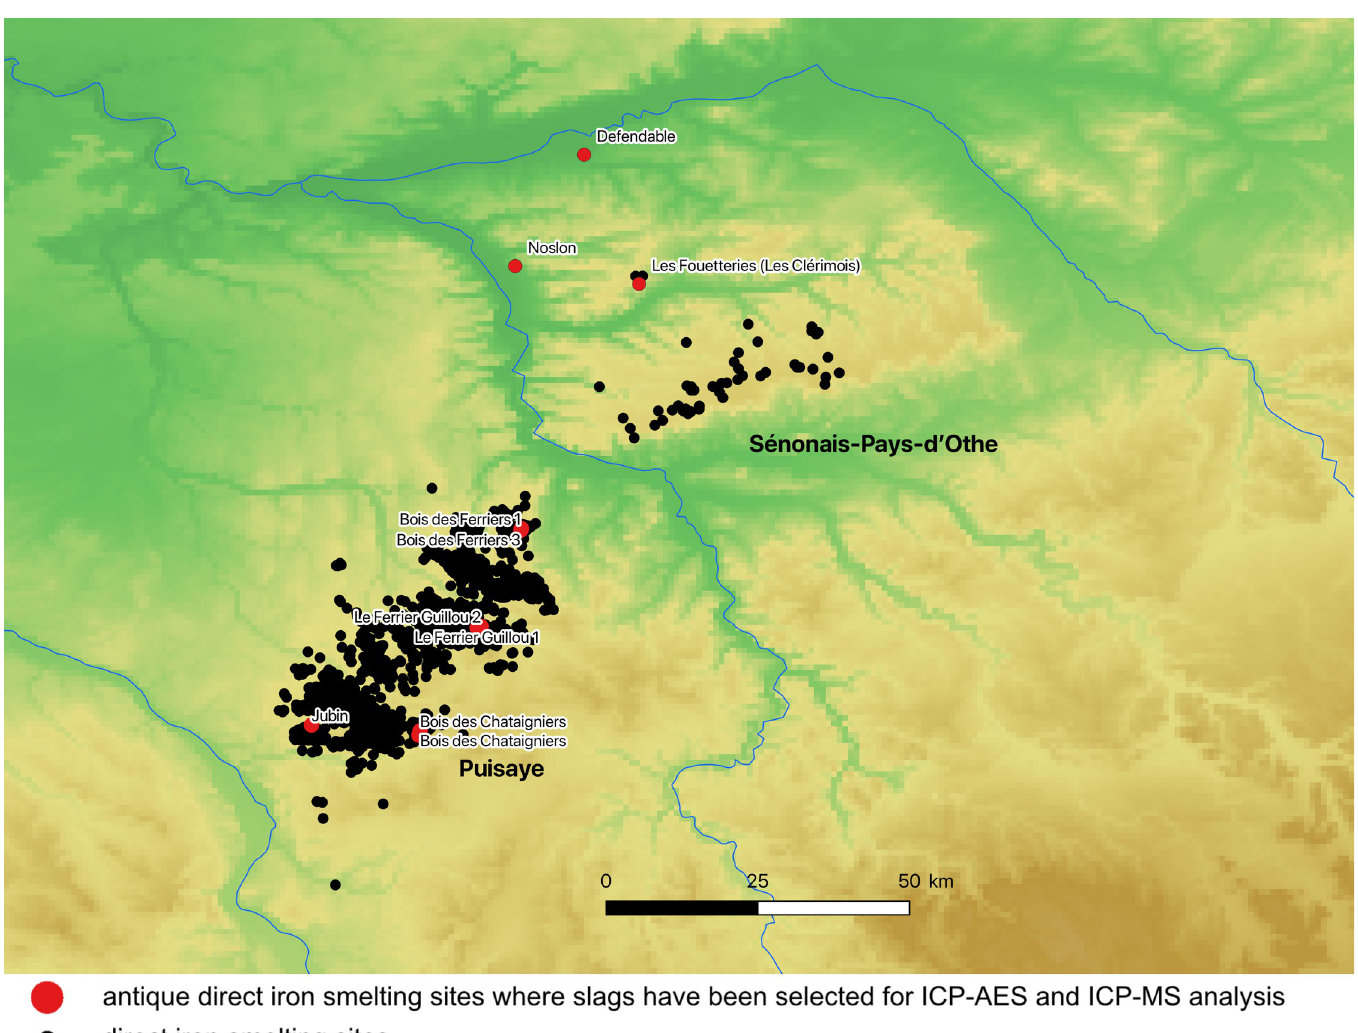
Fig 5. The Puisaye and Se´nonais-Pays-d’Othe iron production areas in France (north at the top; DEM NASA Shuttle Radar Topography Mission Global 1 arc